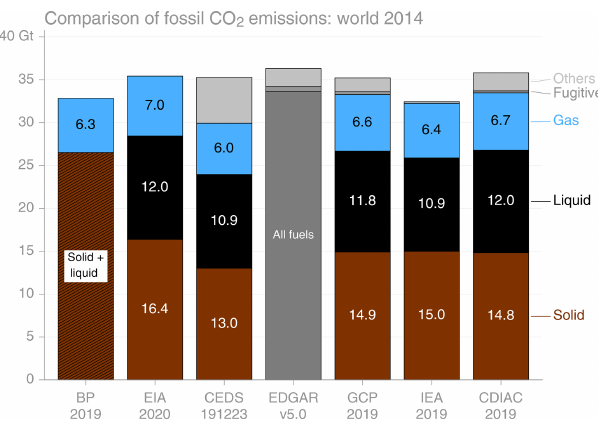
Figure 5. Comparison of global CO 2 emissions for the year 2014 from seven datasets, broken down by fuel type. BP and EDGAR do not report emissions by fuel